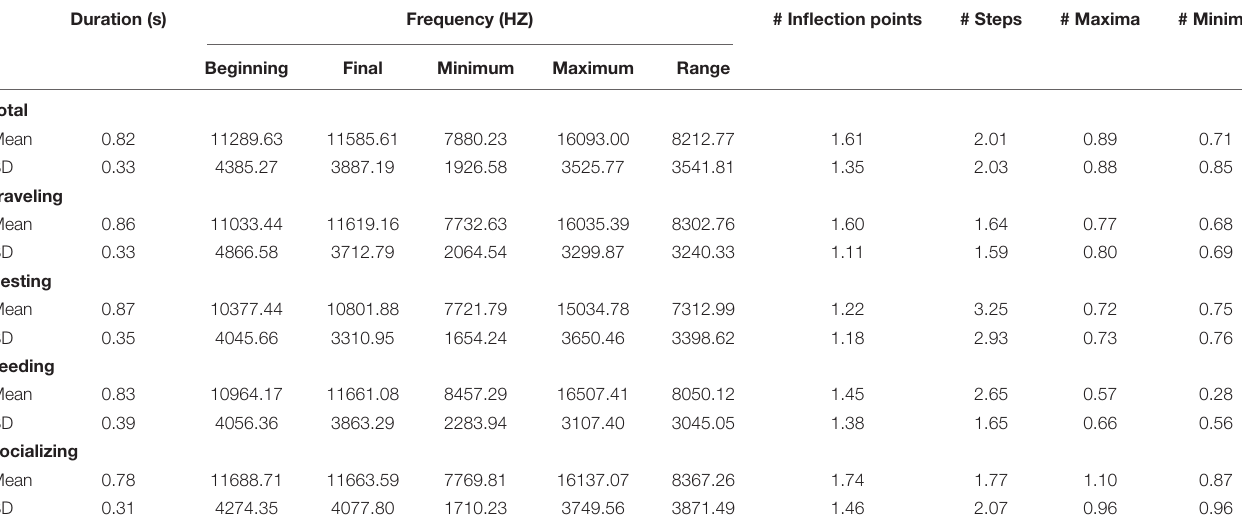
FIGURE 5 | Box plots of the whistle parameters significantly varying among activity class. Black bars represent significant variations between behaviors. TABLE 3 | Mean values (and Standard deviation) of the whistle parameters as a whole and in relation to behaviors. Duration (s) Frequency (HZ) # Inflection points # Steps #